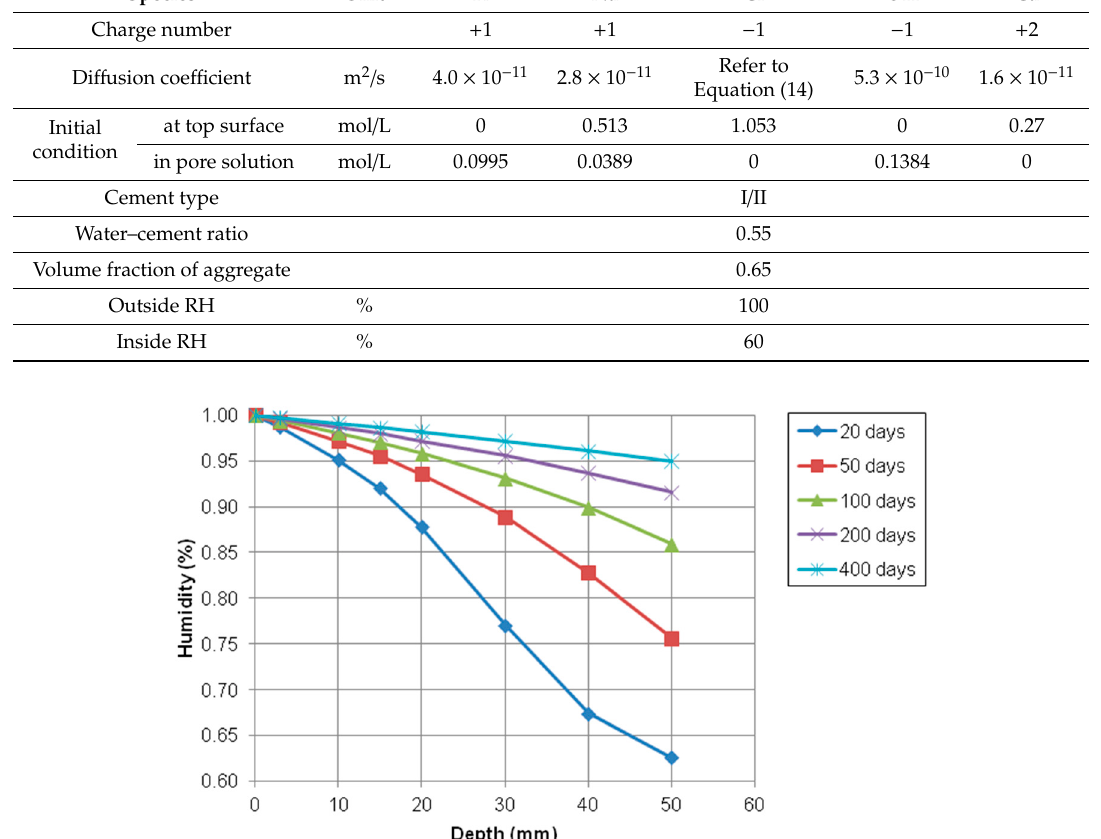
Figure 10. Profile of relative humidity at different depth over time.